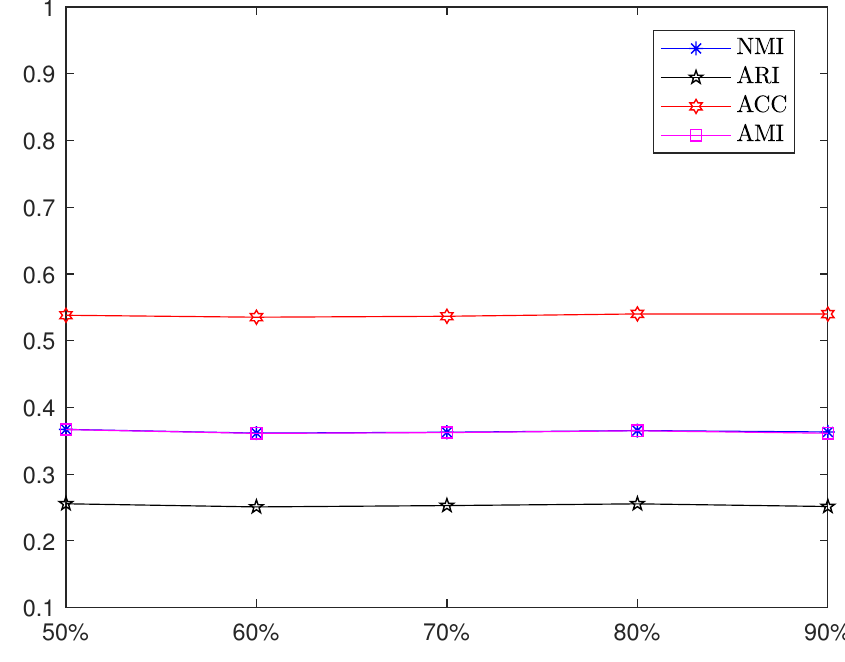
Figure 11. Results of Waveform by